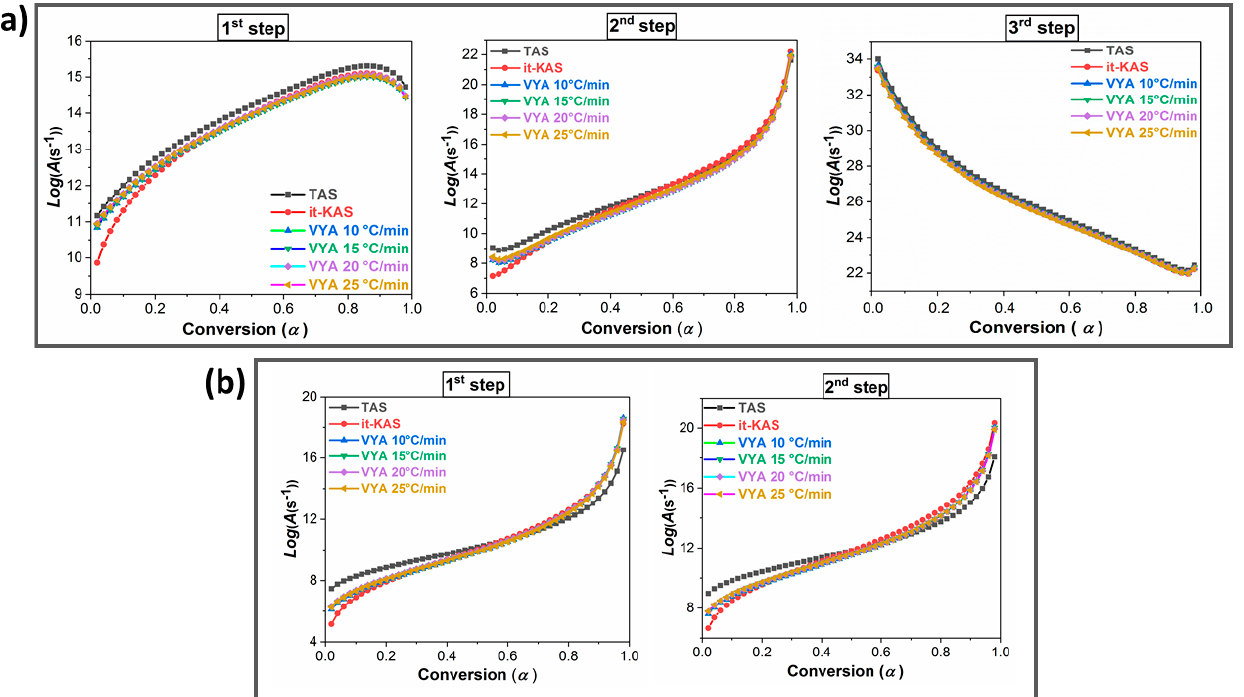
Figure 6. Evolution of the frequency factor as a function of conversion for each decomposition step of ( a ) NC/HNTO/MgAlCuO; ( b ) NNC/HNTO/MgAlCuO.